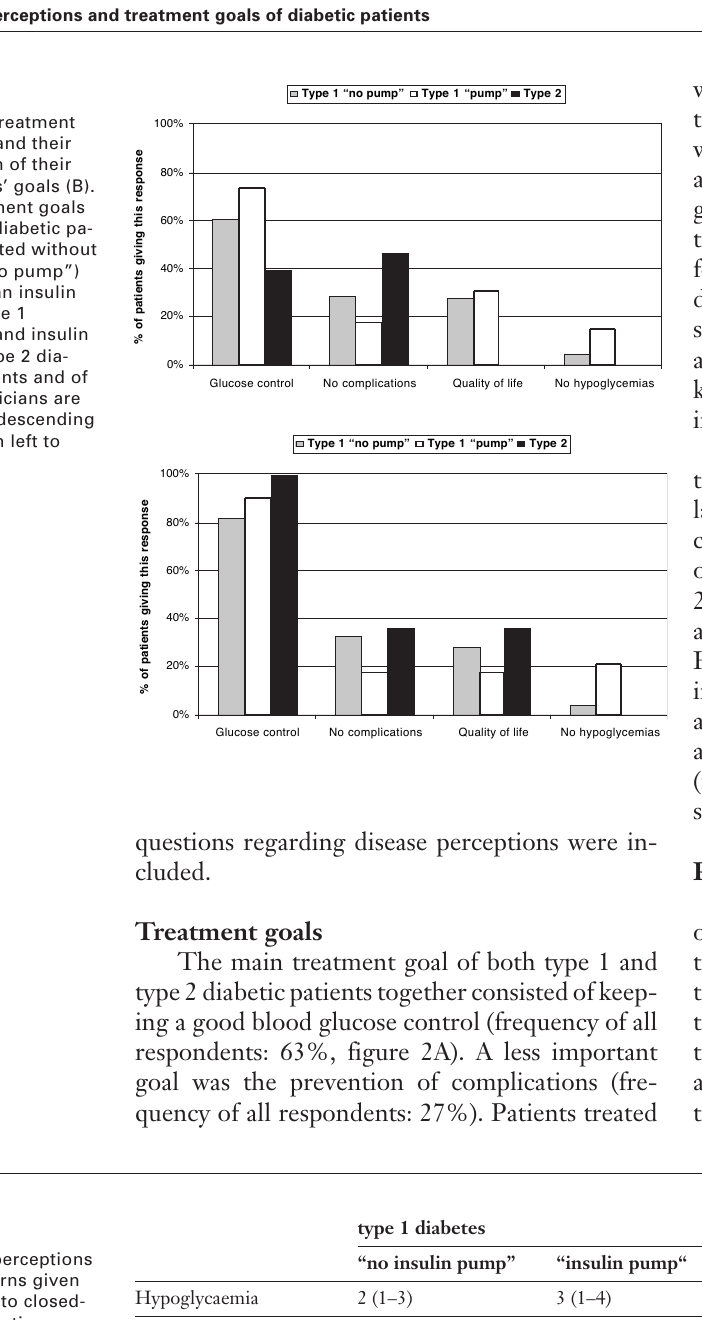
Patients’ perceptions and concerns given in answer to closed- ended questions.